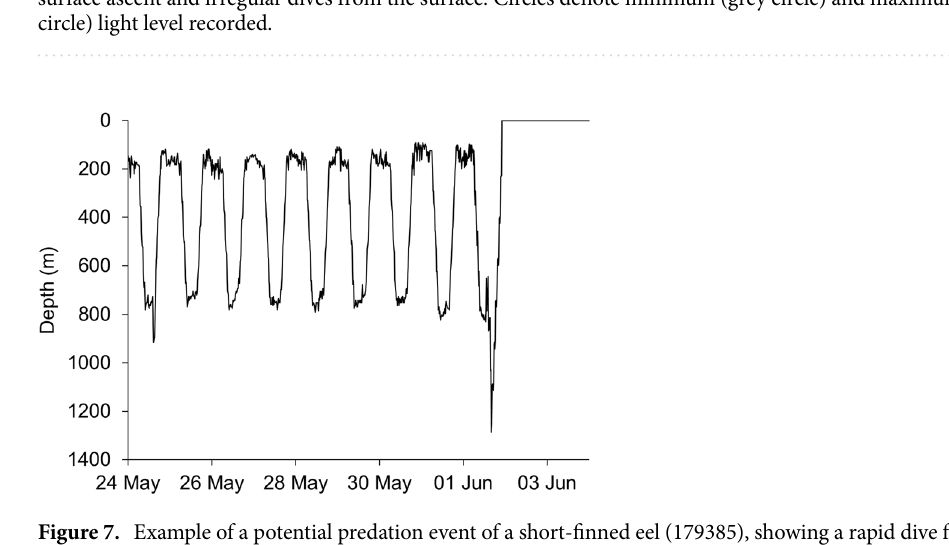
Figure 7. Example of a potential predation event of a short-finned eel (179385), showing a rapid dive from a normal 800-m depth DVM cycle to 1280 m, where the release mechanism was